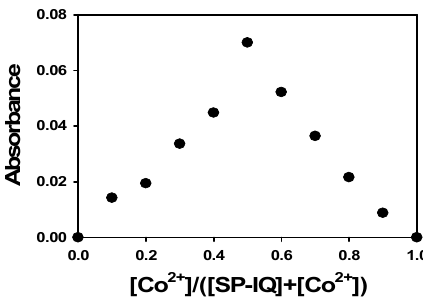
Figure 6. Job plot of SP-IQ and Co 2+ cation. Absorbance at 540 nm for the mixed solutions of SP-IQ and Co 2+ cation after 350 nm UV irradiation for 7 min was plotted as a function of the molar ratio [Co 2+ ]/([ SP-IQ ] + [Co 2+ ]). The total concentration for the mixed solutions of SP-IQ and the Co 2+ cation was 1 × 10 − 5 M.